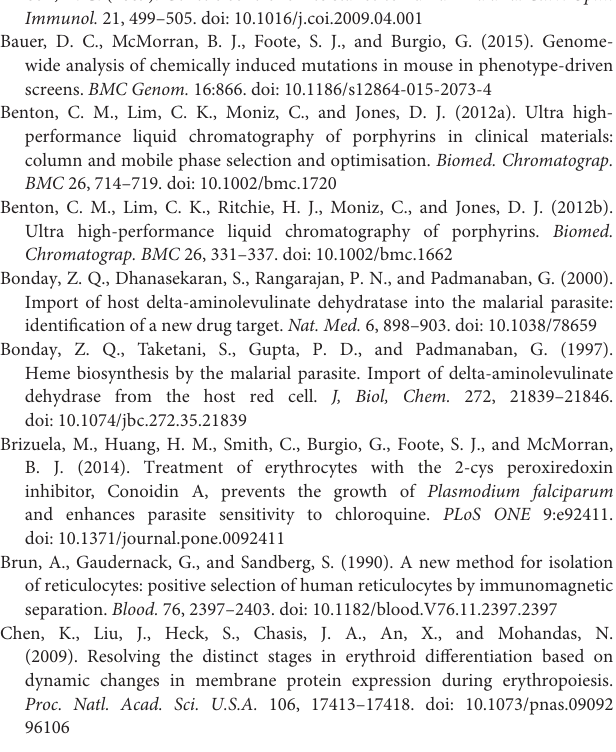
Table S3 | Serum cytokine concentrations in wild-type (n = 5) and Pbgd MRI 58155 heterozygous (n = 8) mice. Table S4 | AIP patient blood